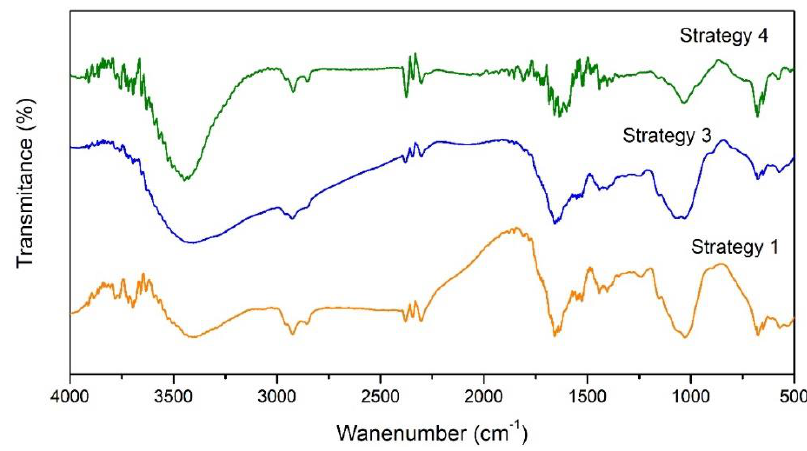
Figure 5. FTIR spectra of the consortium biomass samples from strategies 1, 3, and 4. 345